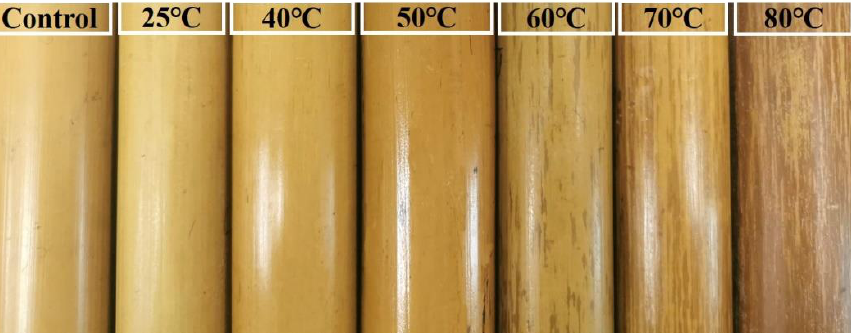
Figure 2. Effect of rosin treatment with different temperature on the color and gloss of bamboo culm.